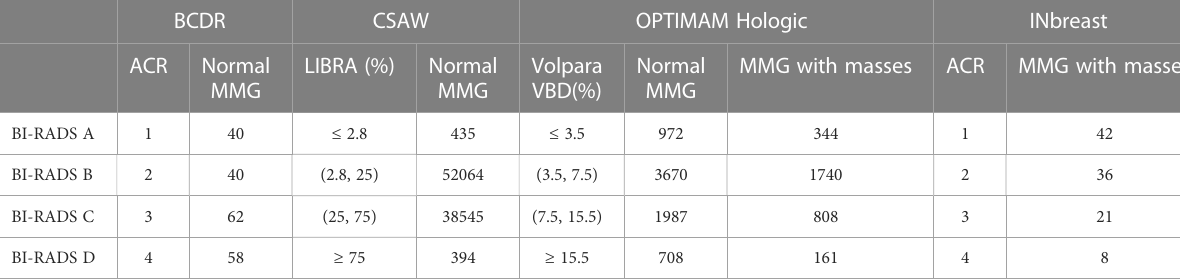
TABLE 1 Digital mammography datasets used in this